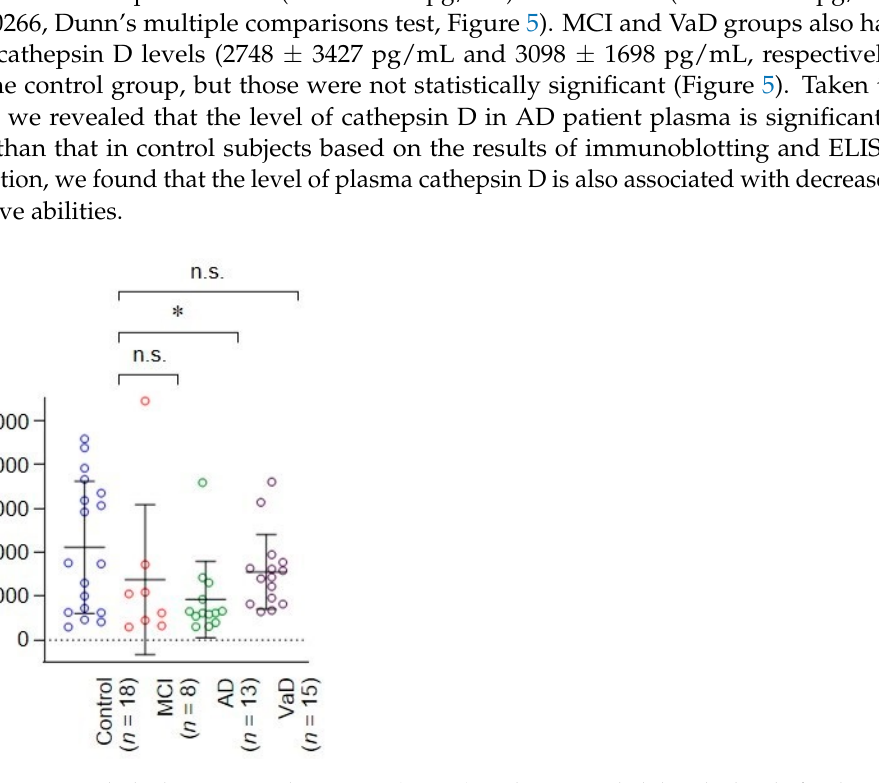
Figure 5. Enzyme-linked immunosorbent assay (ELISA) analysis revealed that the level of cathepsin D. * p < 0.05, n.s., not significant, Kruskal-Wallis test, followed by Dunn’s multiple comparisons test.